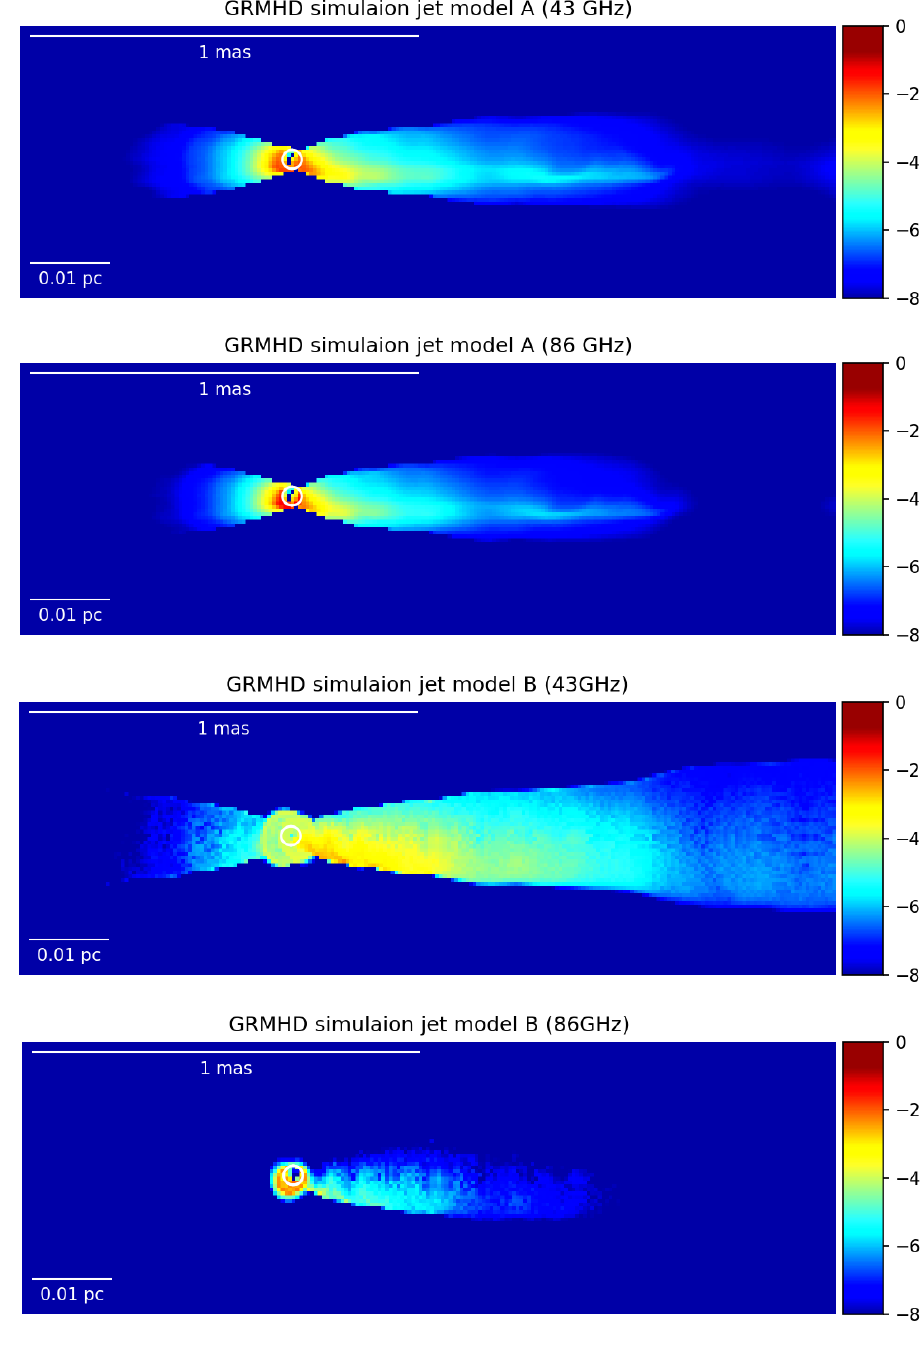
Figure 4. Model synchrotron images at 43 and 86 GHz for GRMHD jet models A and B. The projected black hole axis is pointing to the right. The images are shown on a logarithmic scale. For reference, the size of the black hole shadow is indicated by the white circle near the jet base. The color bar indicates